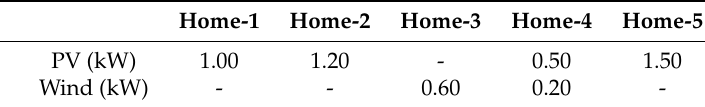
Table 3. Distributed genenation system